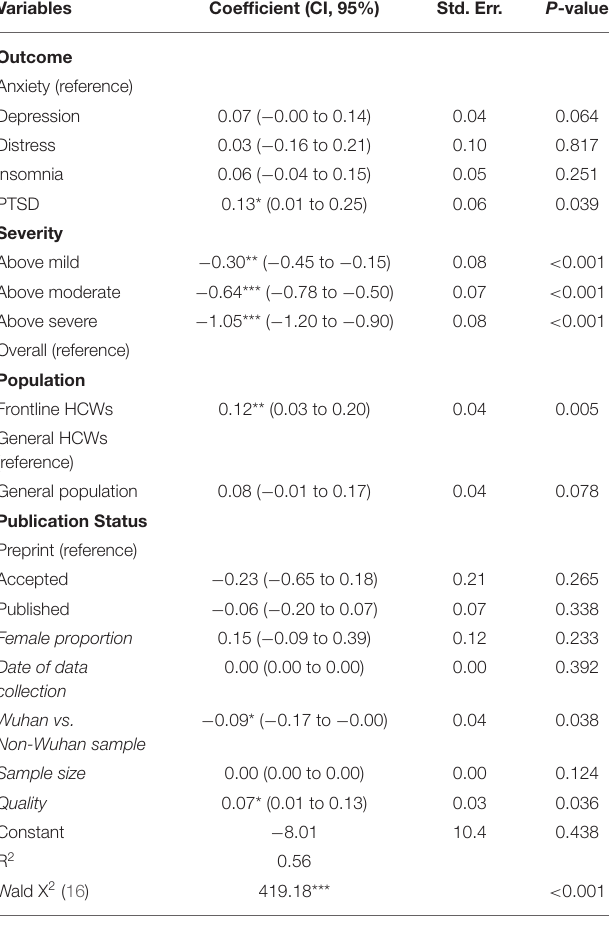
TABLE 3 | The results of meta-regression of mental health symptoms during COVID-19.